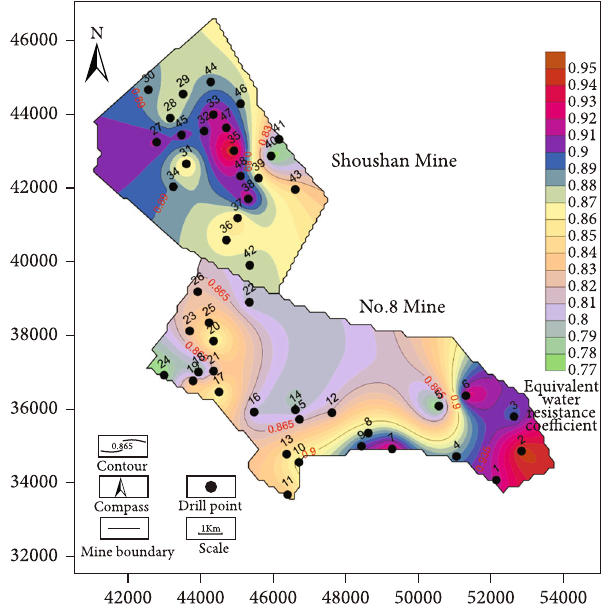
Figure 5: Contour map of the equivalent water resistance coe ffi